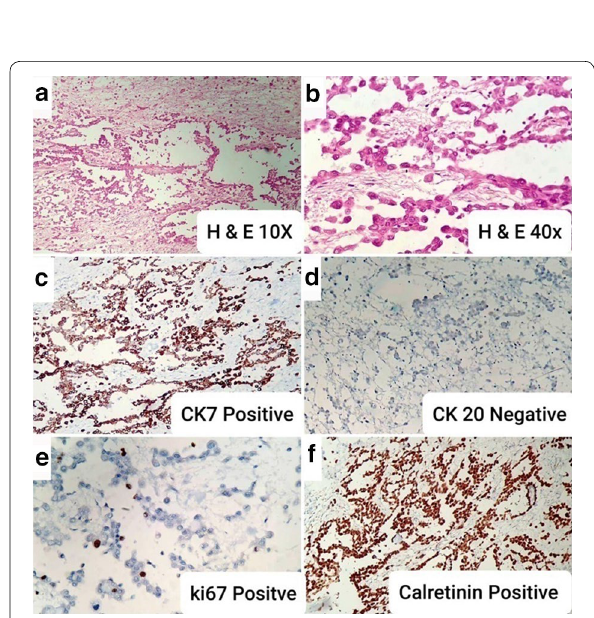
) with a relatively normal appearing +